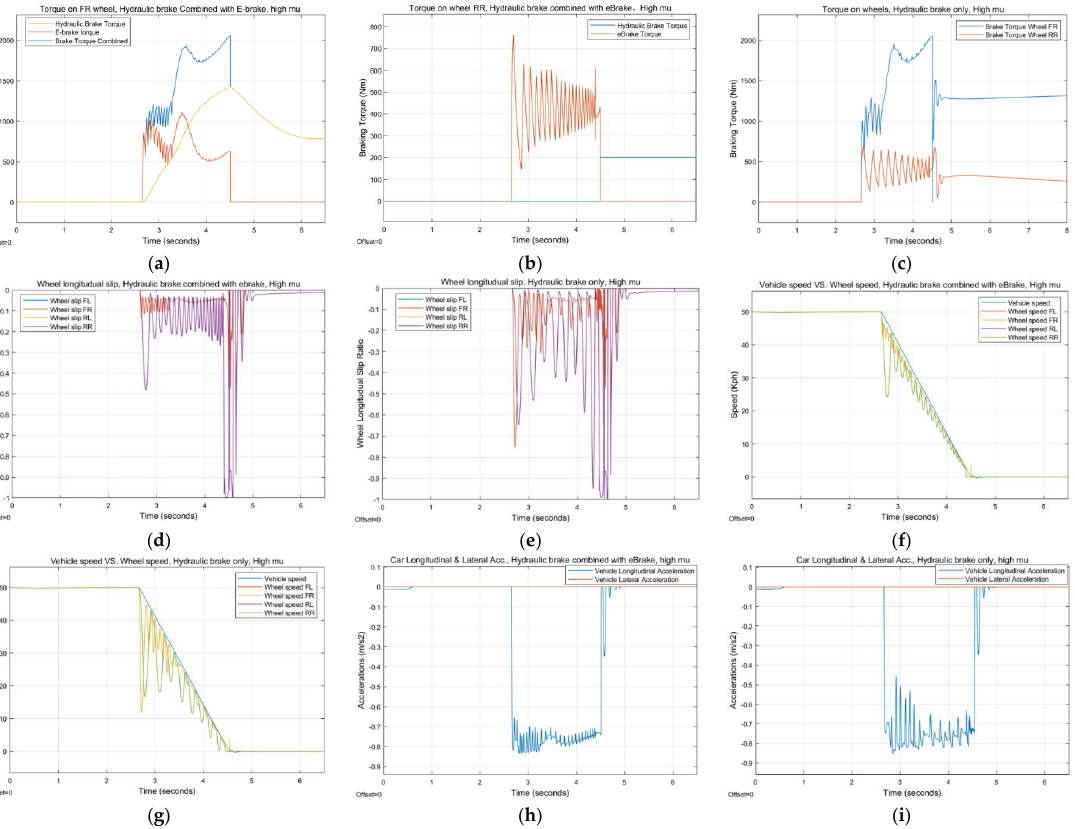
Figure 9. Simulation results for AEBS validation in high 𝜇 road. ( 𝜇 = 0.85 ) ( a ) Total braking torque, torque of RBS and HBS on wheel FR of ego vehicle; ( b ) torque of RBS and HBS on wheel RR of ego vehicle; ( c ) HBS torque on wheel FR and wheel RR of ego vehicle; ( d ) longitudinal slip ratio of wheels of ego vehicle, RBS+HBS; ( e ) longitudinal slip ratio of wheels of ego vehicle, HBS only; ( f ) vehicle speed vs. wheel speed of ego vehicle, RBS+HBS; ( g ) vehicle speed vs. wheel speed of ego vehicle, HBS only; ( h ) longitudinal and lateral acceleration of ego vehicle, RBS + HBS; ( i ) longitudinal and lateral acceleration of ego vehicle, HBS only.